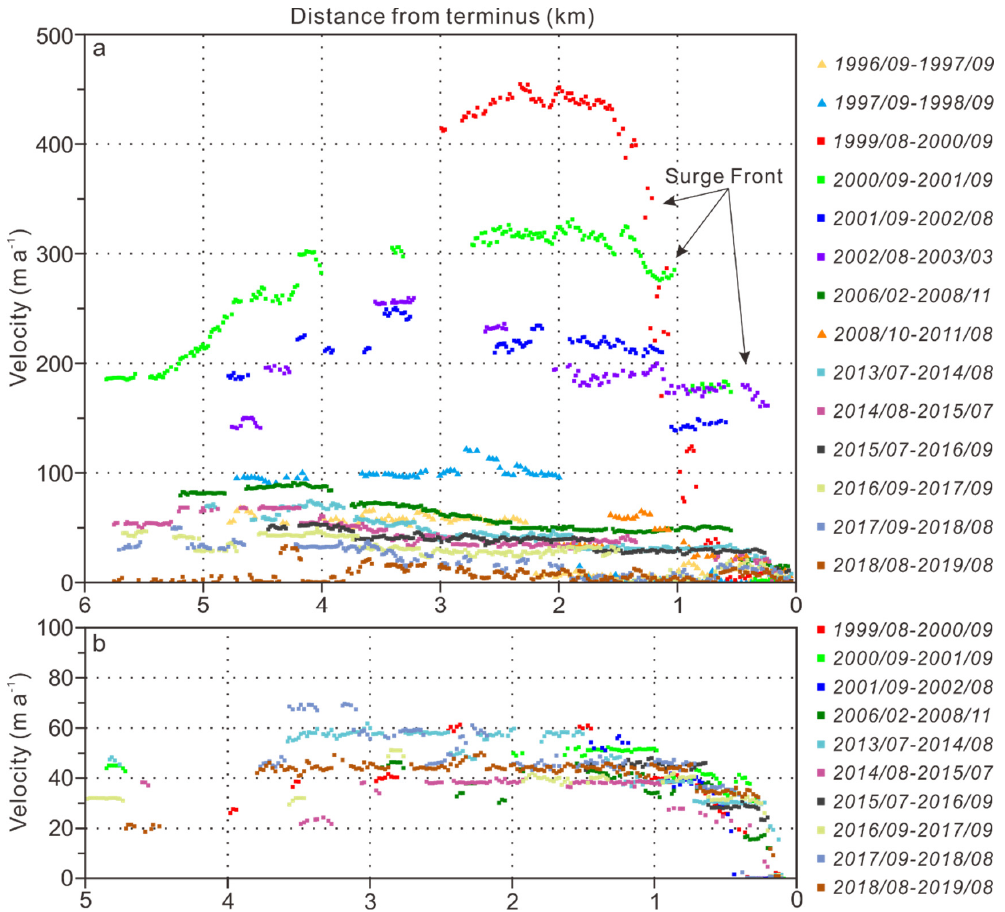
Figure 4. Centre line annual-velocity profiles for the studied glaciers: ( a ) Glacier S and ( b ) Glacier A. Note that velocity profiles extracted from Landsat 5 images are presented using small triangles in ( a ).